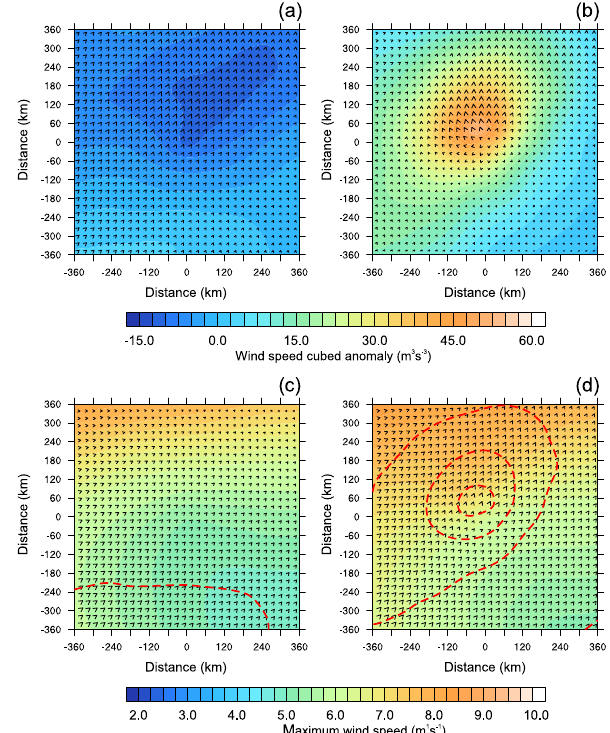
Figure 8. Composites around column rainfall exceeding 1mmh − 1 . Composited time includes the point of threshold exceedance and the following 6h of the simulation. Panels (a, b) show the wind speed cubed anomaly for 12km simulations with parameterised and ex- plicit convection respectively, arrows represent wind anomaly. Pan- els (c, d) show composites of the maximum wind speed in the rainfall to rainfall + 6h window for 12km simulations with pa- rameterised and explicit convection; arrows represent composite winds and red dashed lines represent wind speed cubed anomaly at 15m 3 s − 3